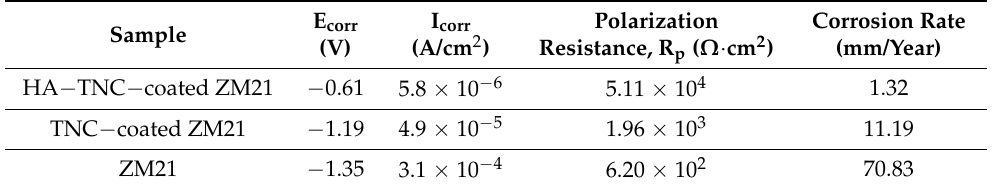
Figure 5. ( a ) PDP curves, ( b ) Nyquist plots of HA-TNC-coated ZM21, TNC-coated ZM21, and the polished ZM21 Mg sample. Table 1. The fitted parameters of PDP curves for the HA-TNC−coated ZM21, TNC-coated ZM21, and polished ZM21 Mg alloy.